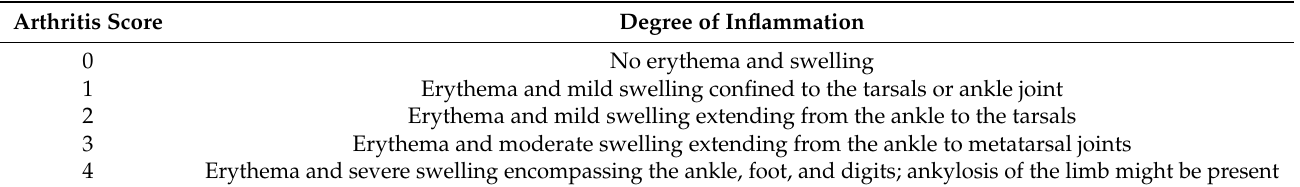
Table 2. The arthritis scoring